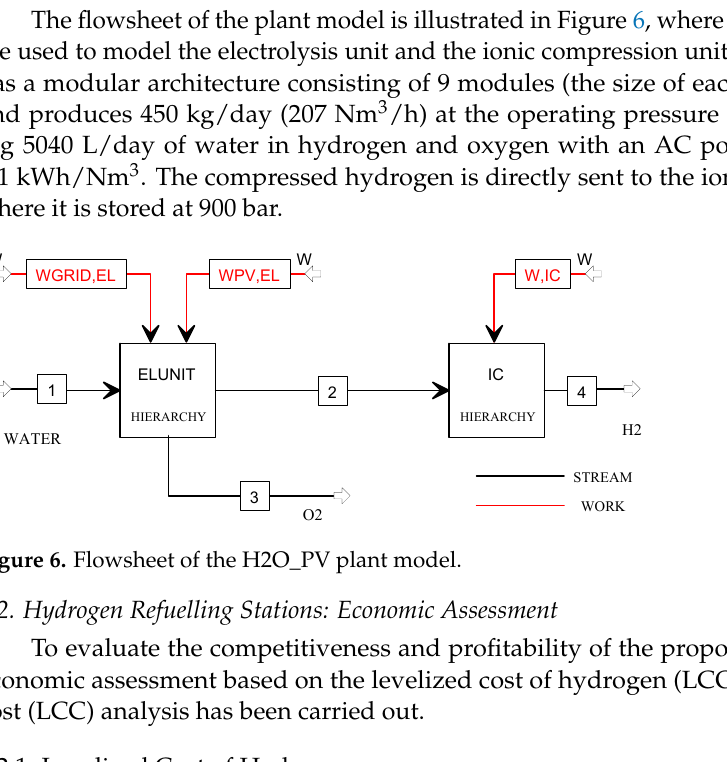
Figure 5. The annual energy production of the single PV module.